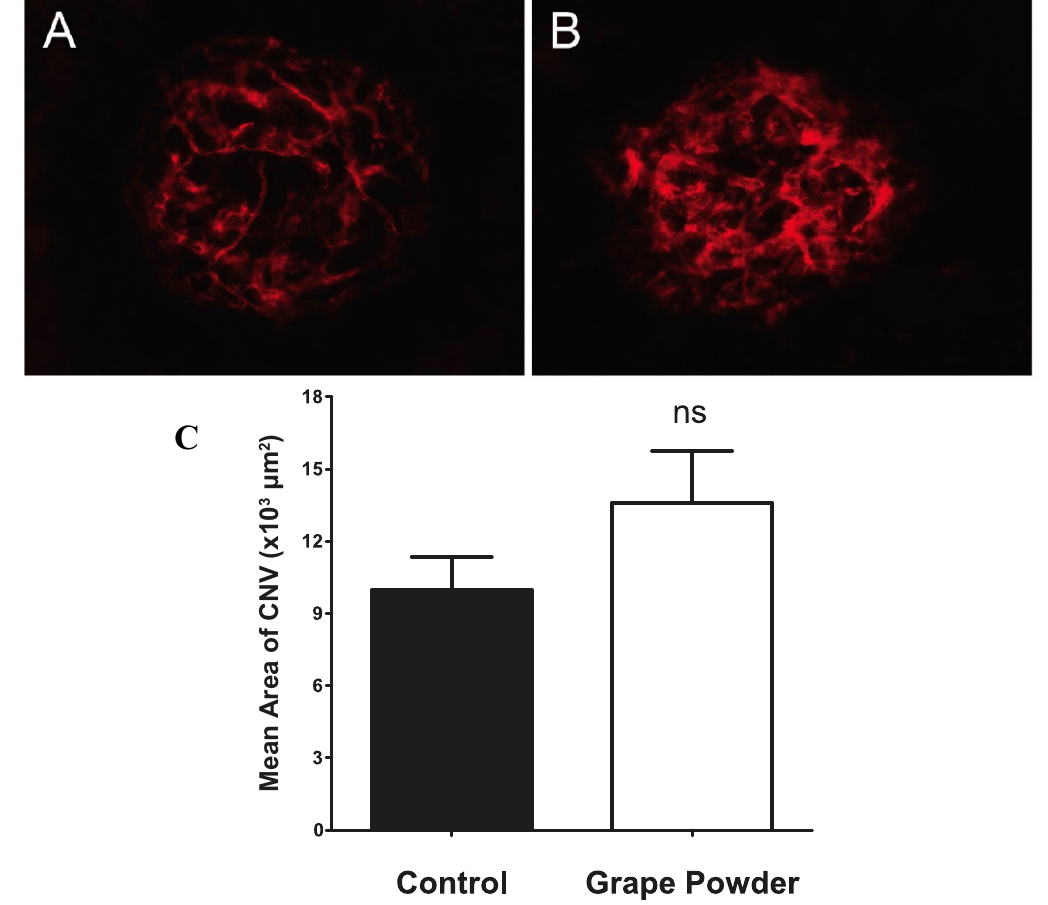
Figure 4. Single daily delivery of reconstituted grape powder enhances blood vessel formation in a mouse model of CNV. Representative sclerochoroidal flat mounts from mice receiving vehicle ( A ) or reconstituted grape powder ( B ) once daily by oral gavage. Treatment began five days prior to the induction of CNV and continued for a total